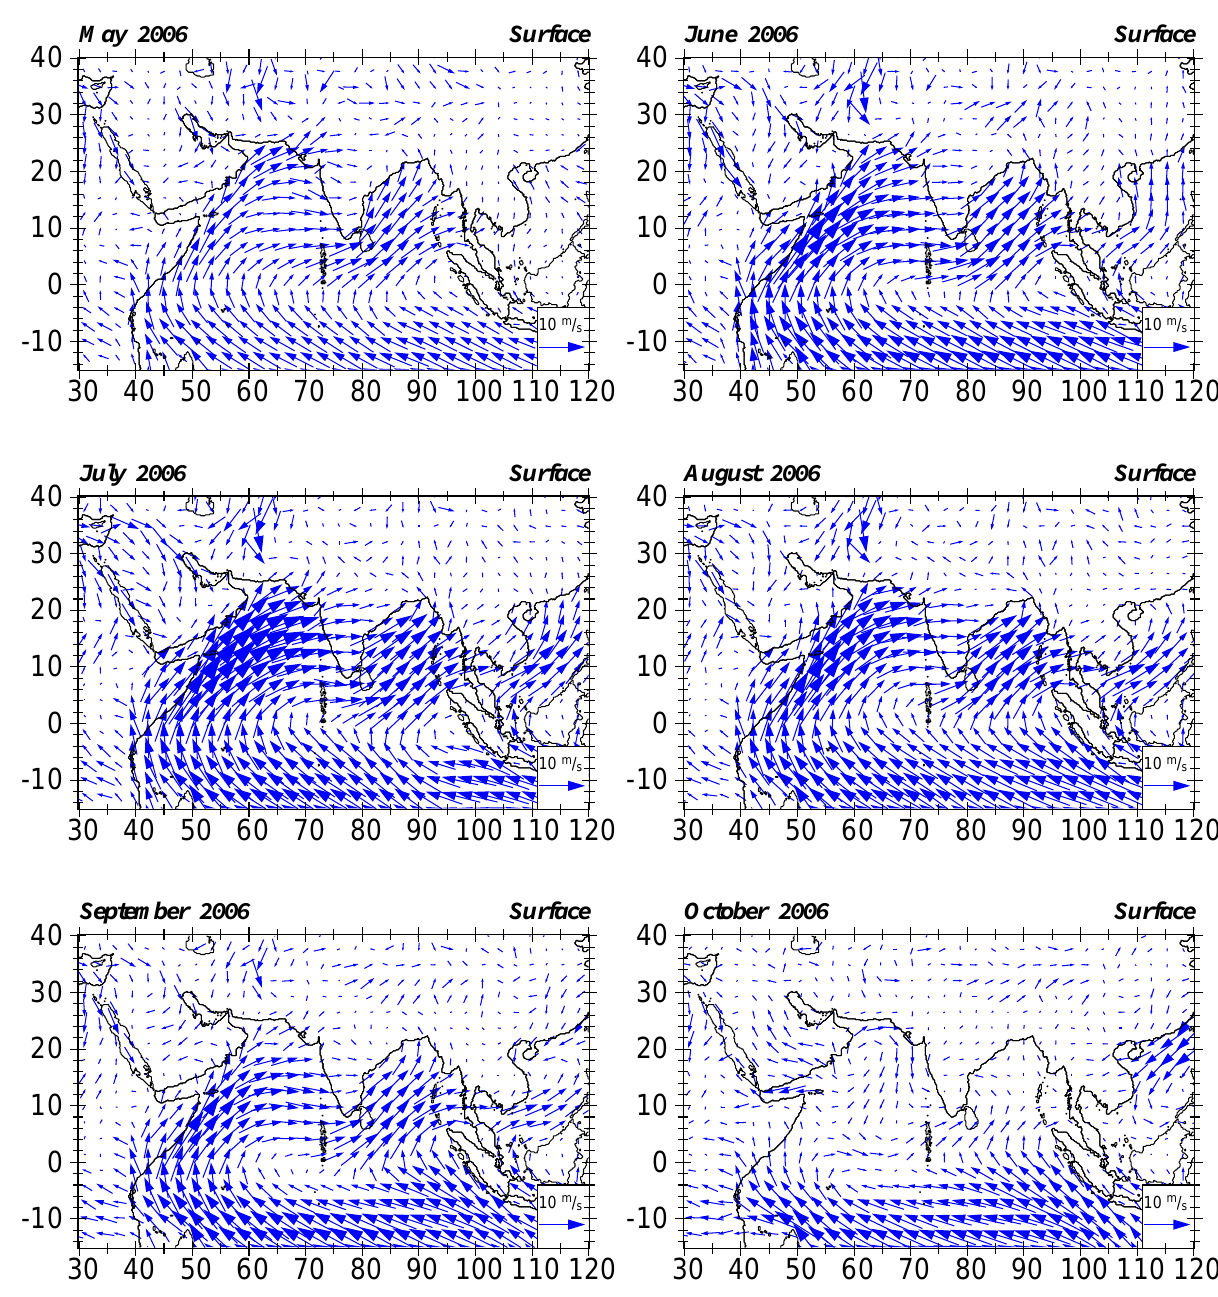
Fig. 6. Surface wind fields over southern Asia for each month in 2006, based on NCEP-GFS data, showing the typical summer and winter monsoon flow patterns that are depicted schematically in Fig.